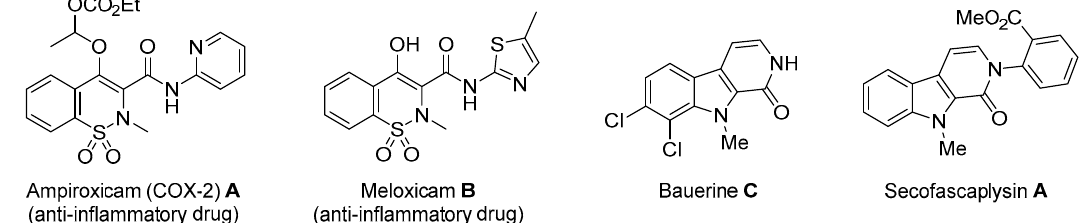
Figure 1. General structures of synthesized cores.